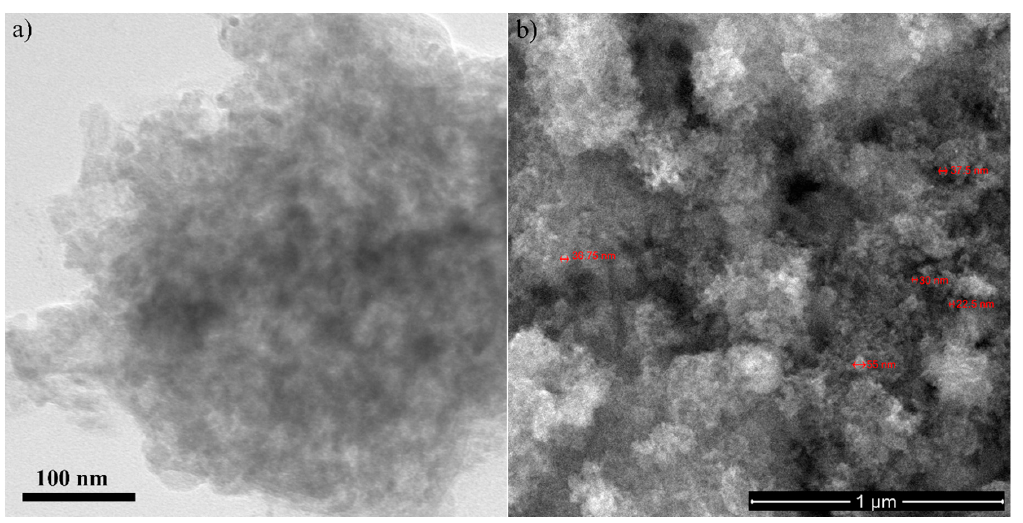
Figure 2. TEM analysis ( a ) and SEM image ( b ) of the 5Ce-HAp suspension. (Ce-HAp agglomerates are depicted in red). 5Ce-HAp: cerium-doped hydroxyapatite (Ce-HAp) with x Ce = 0.05. Coatings 2020 , 10 , x FOR PEER REVIEW